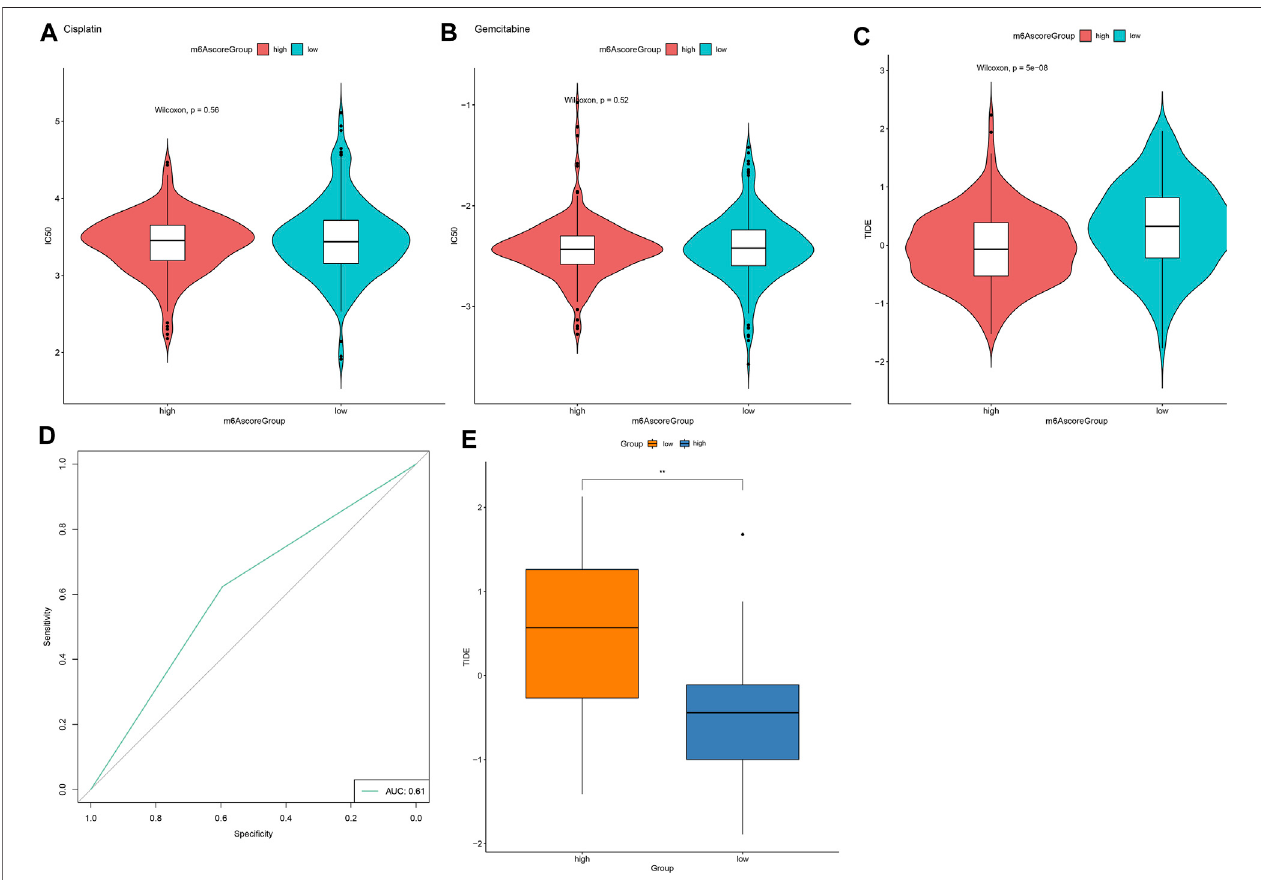
FIGURE8 | m 6 Ascoremightbeusedforpredictingtheresponsetoimmunotherapy. (A,B) ViolinplotsforvisualizingIC50valuesof (A) cisplatinand (B) gemcitabineinhigh andlowm 6 Ascoregroups. (C) ViolinplotsofTIDEscoresinhighandlowm 6 Ascoregroups.ComparisonsbetweengroupswereanalyzedwithWilcoxontest. (D) ROCcurvesfor assessing the response to immunotherapy based on m 6 A scores. (E) Validation of TIDE scores in high and low m 6 A score groups in the GSE79668 dataset. ** p < 0.01.